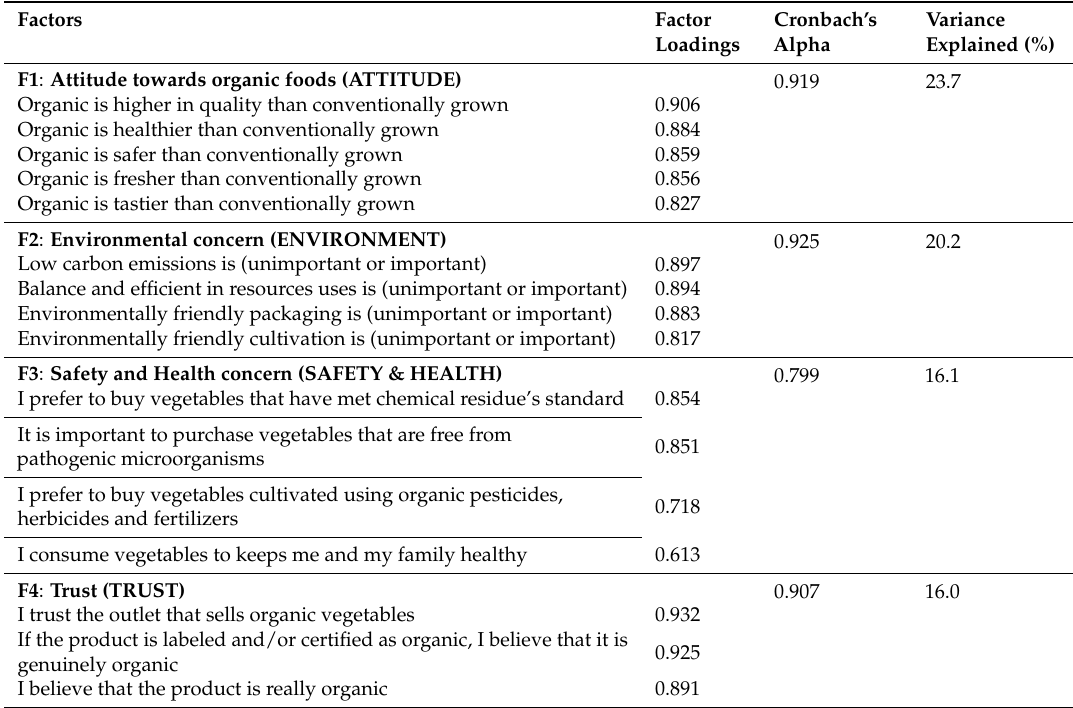
Table 3. Summary of factor analysis